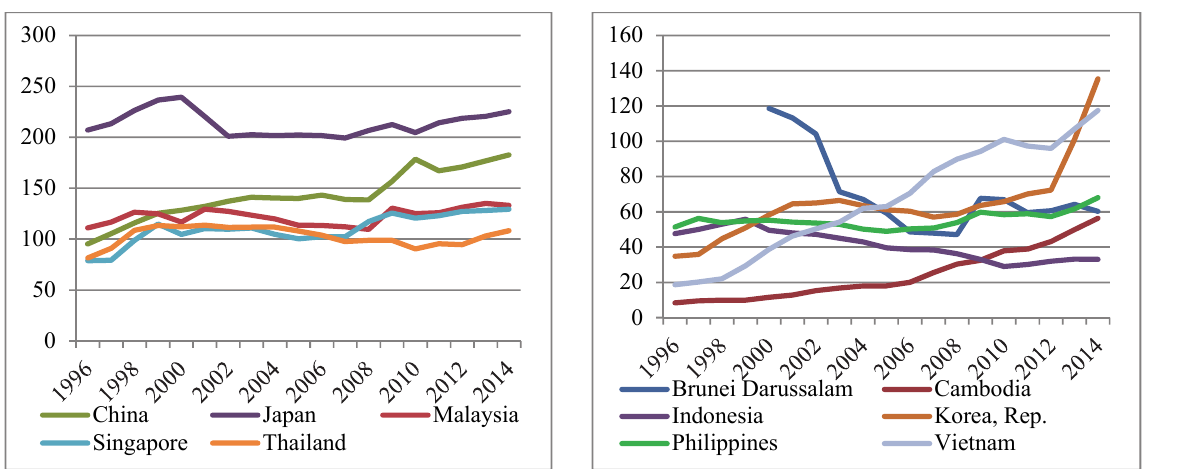
Fig. 4. Liquid liabilities in less developed finan- cial systems (% of